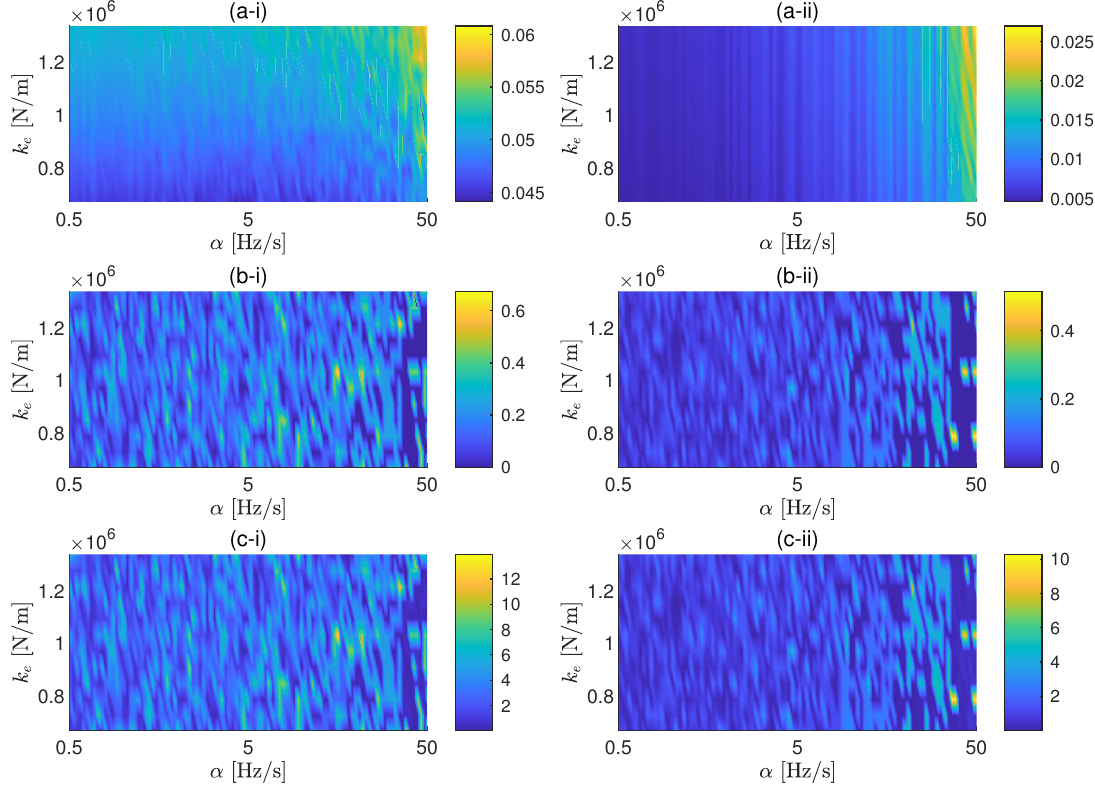
Figure 3. General ( a ), resonance frequency ( b ) and resonance amplitude ( c ) errors as a function of the sweep rates and the dynamic stiffness of the elastomer for excitation force amplitudes of 1.5 N (i) and 15 N (ii). Background noise: 3.3 × 10 − 10 m/s 2